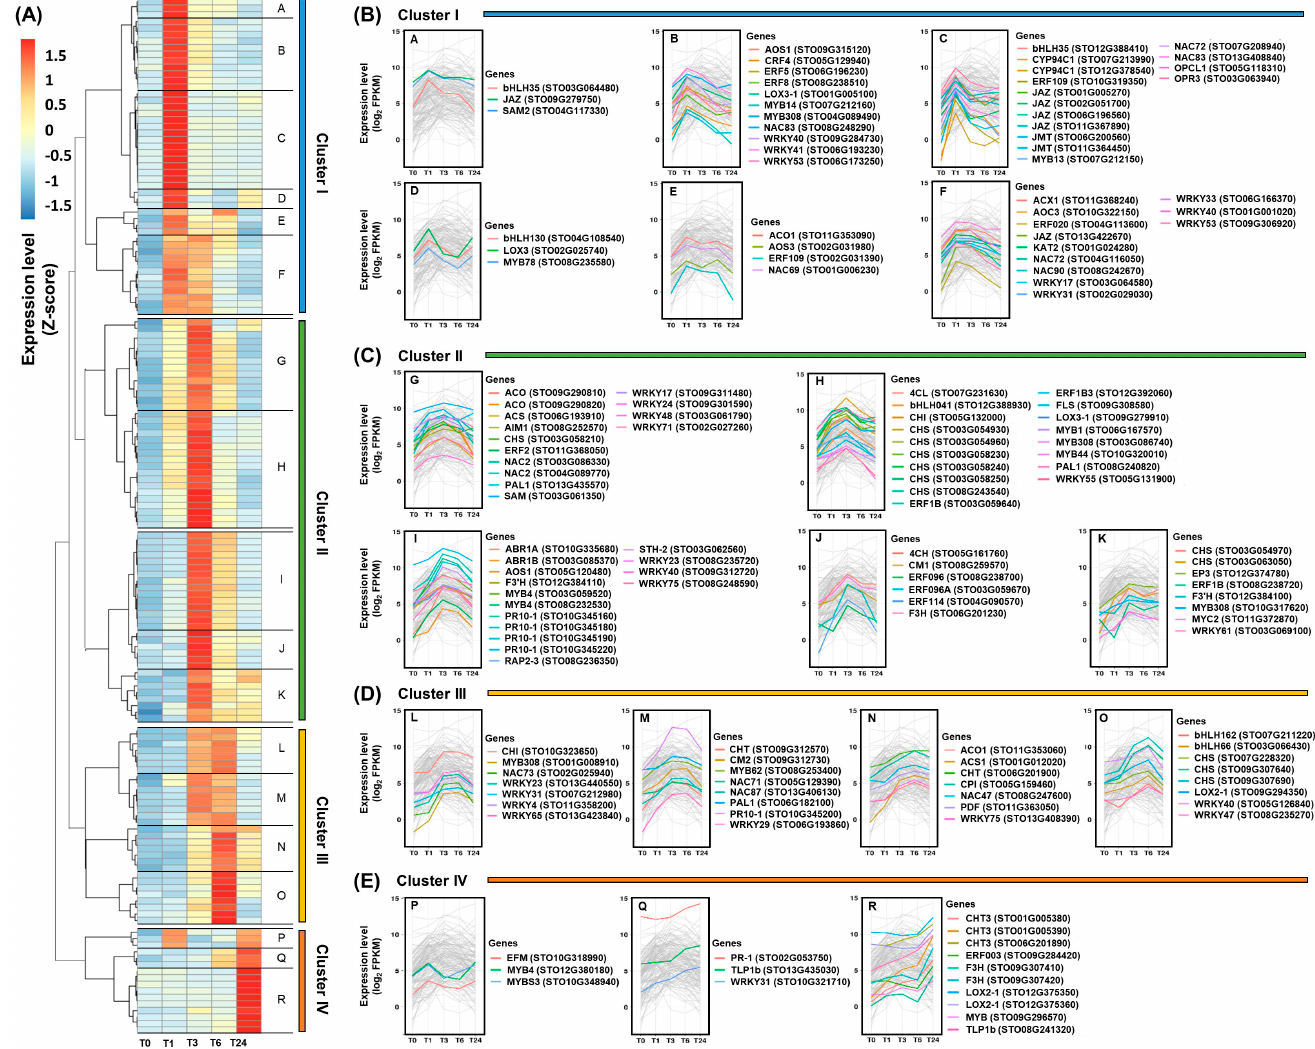
Figure 7. Co-expression analysis of the differentially expressed genes (DEGs) induced by wounding in the S . tora leaves based on the expression patterns. ( A ) Heatmap analysis of selected DEGs. The fragments per kilobase of transcript per million mapped reads (FPKM) values for each individual gene were normalized to the Z-score. The heatmap was visualized using the pheatmap package in R. Statistical analysis was performed on the expression levels of each gene expressed at the different times compared with T0 (Table S6). ( B – E ) Analysis of the co-expression of selected DEGs using a line graph. The expression levels were calculated using the log 2 scale of each gene FPKM. Genes with a fold change below three and a FPKM below 10 were excluded from the co-expression